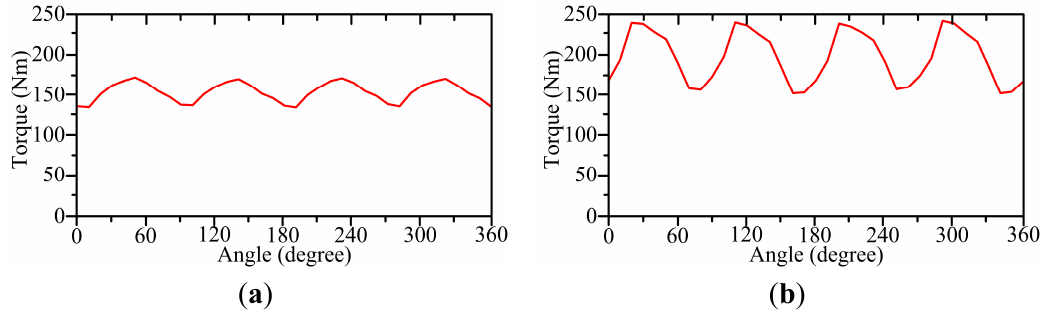
Figure 11. Torque waveforms at bipolar conduction scheme: ( a ) rated DC-field excitation; and ( b ) strengthened DC-field excitation.